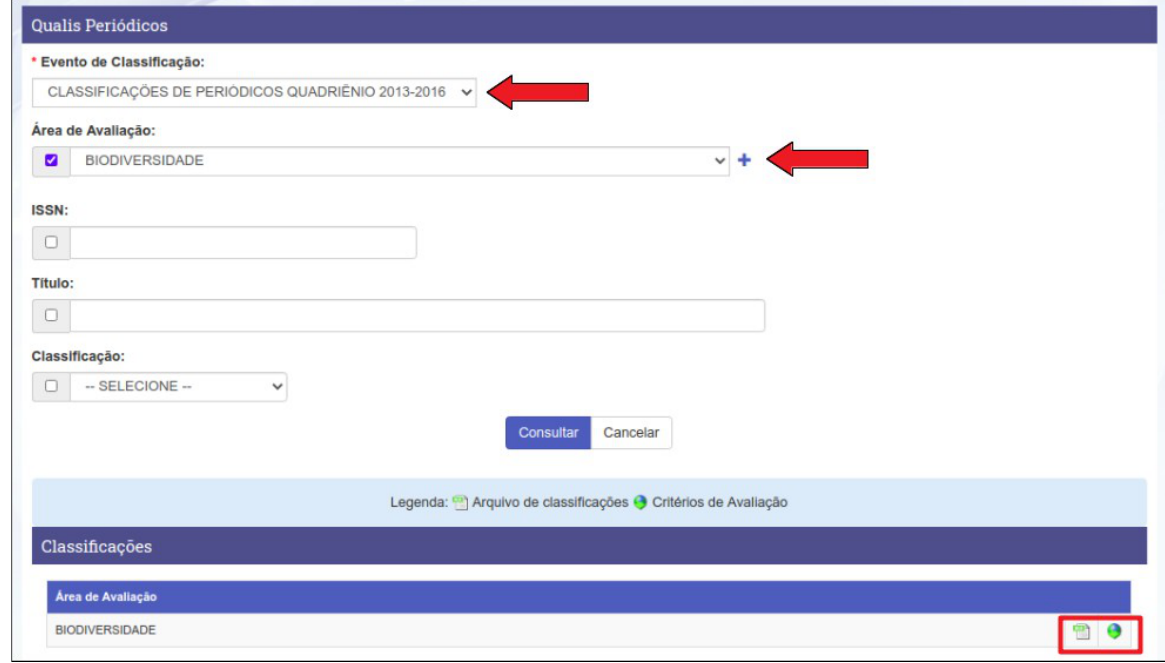
Figure S4. Number of journals classified as A1 having a Scopus CiteScore below the median CiteScore for each subject area, across all 49 QUALIS subject areas. Original QUALIS subject area names are shown (as written in their respective classification sheets) but their English translation can be found in Table